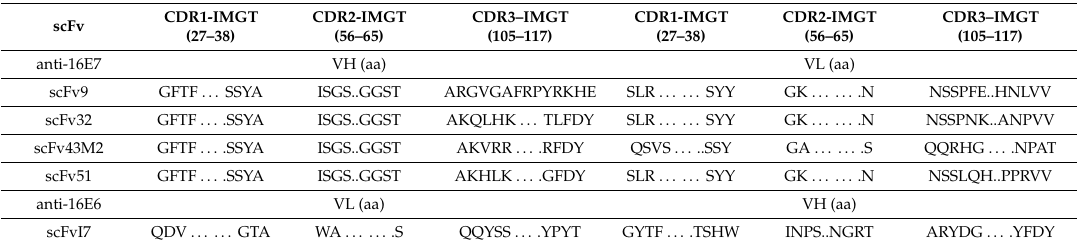
Table 1. Complementarity-determining Regions (CDRs) of the Anti-16E7 and -16E6 ScFvs.